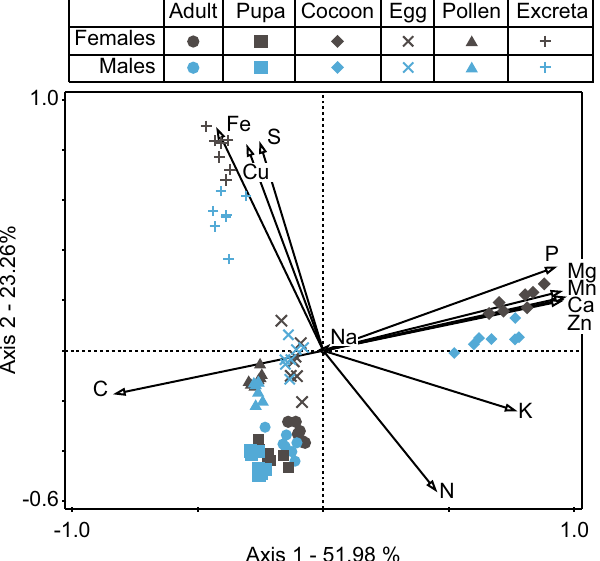
Figure 2. General pattern of elemental partitioning between different components of the elemental budget. PCA plot—the whole elemental budget of O. bicornis and stoichiometric relations between its components; calculated according to the concentrations of elements. Note that the body and cocoon add up to the total production that is built based on the food eaten during larval growth—pollen. The first two axes are presented. The percentage of variation explained is given for both axes. The lengths of vectors represent the contribution of every element to the pattern shown (longer vector = greater contribution). The direction of the vector shows the axis to which it contributes. Detailed results are shown in the supplement. The adult body is the component richest in N, cocoon is the component richest in P, Mg, Mn, Ca and Zn, and excreta are the richest in Fe, S and Cu. C:P ratio is decreasing from left to right along the wide line between pupa and cocoon. A detailed analysis of sexual differences is shown in Fig.